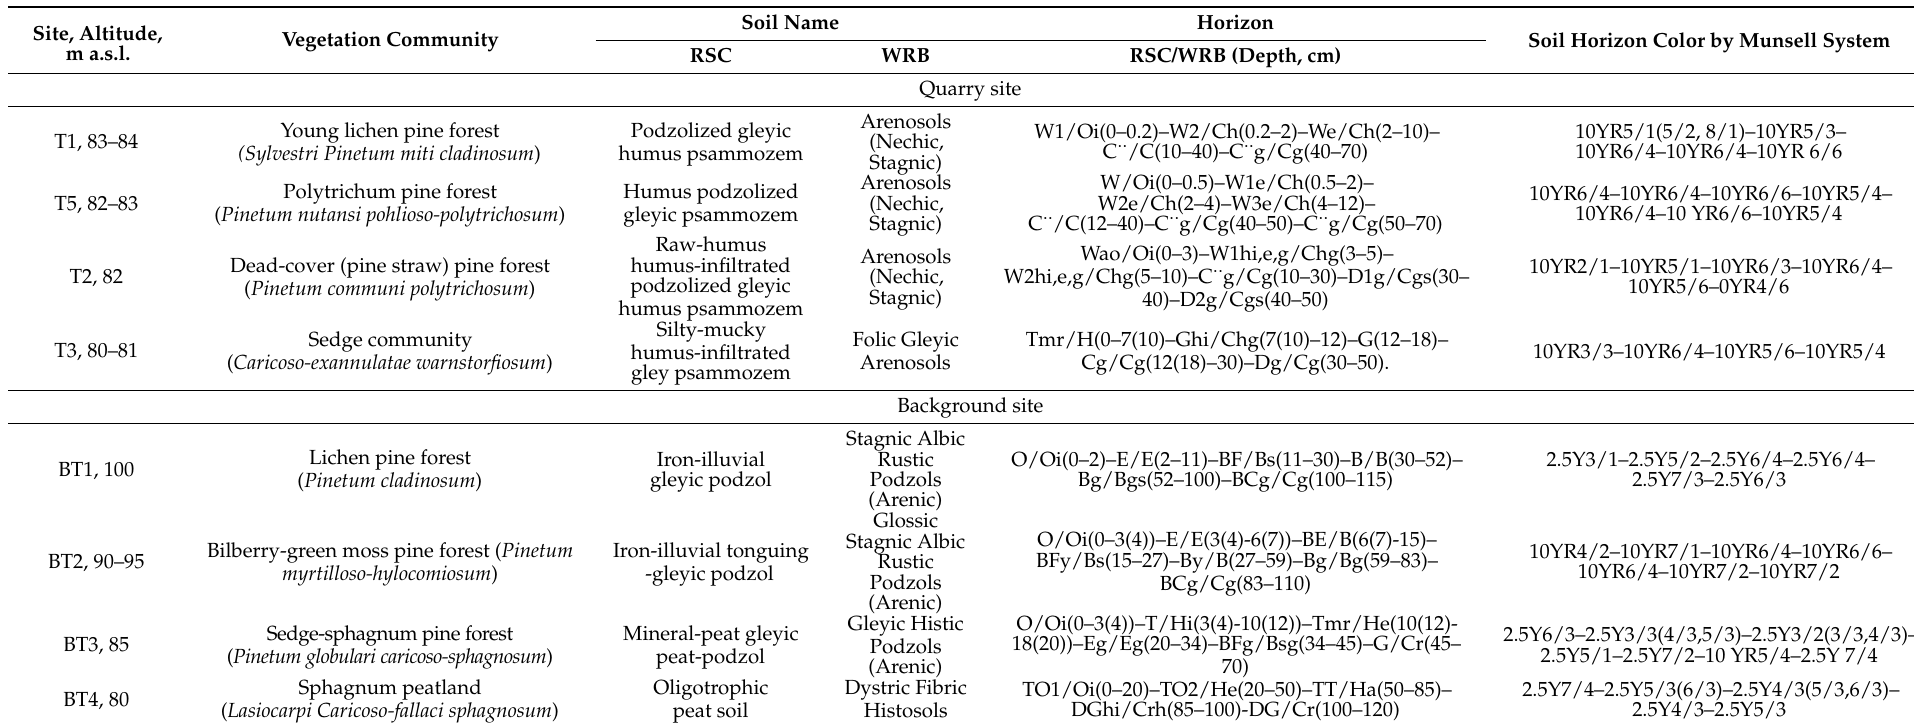
Table 1. Description of the study